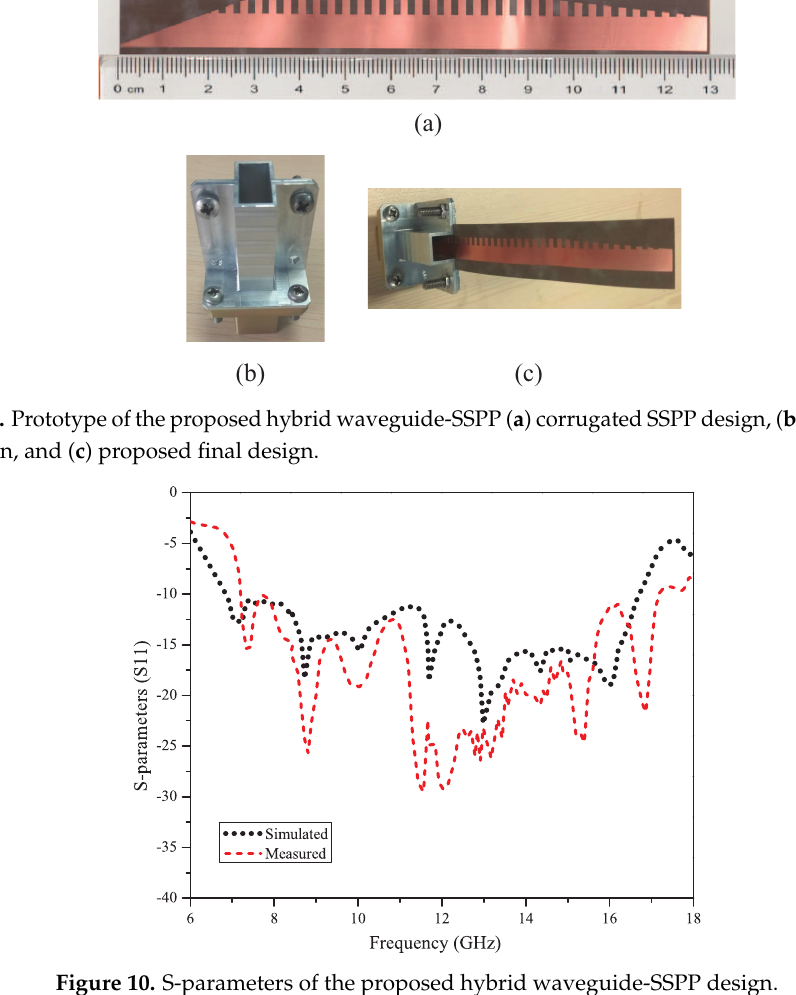
Figure 10. S-parameters of the proposed hybrid waveguide-SSPP design.